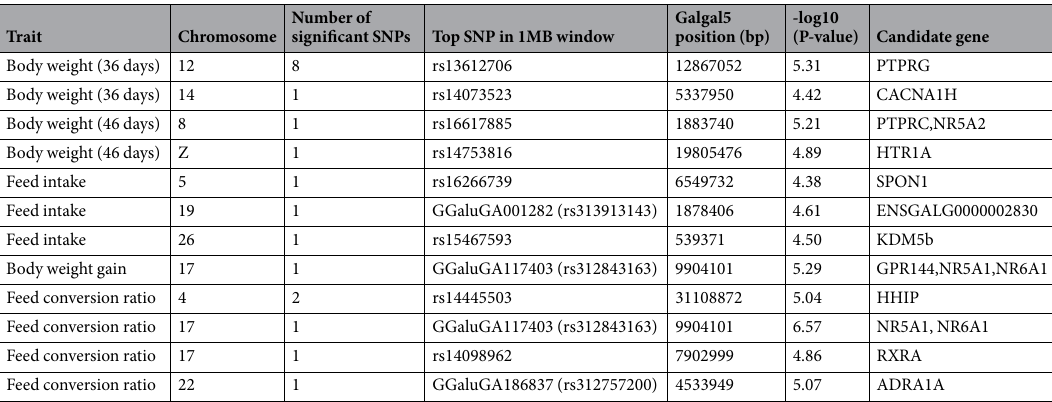
Table 2. Top SNPs associated with body weight and feed efficiency traits using general linear model approach by Reyer et al . (2015). The position of SNPs is updated to the latest chicken genome assembly